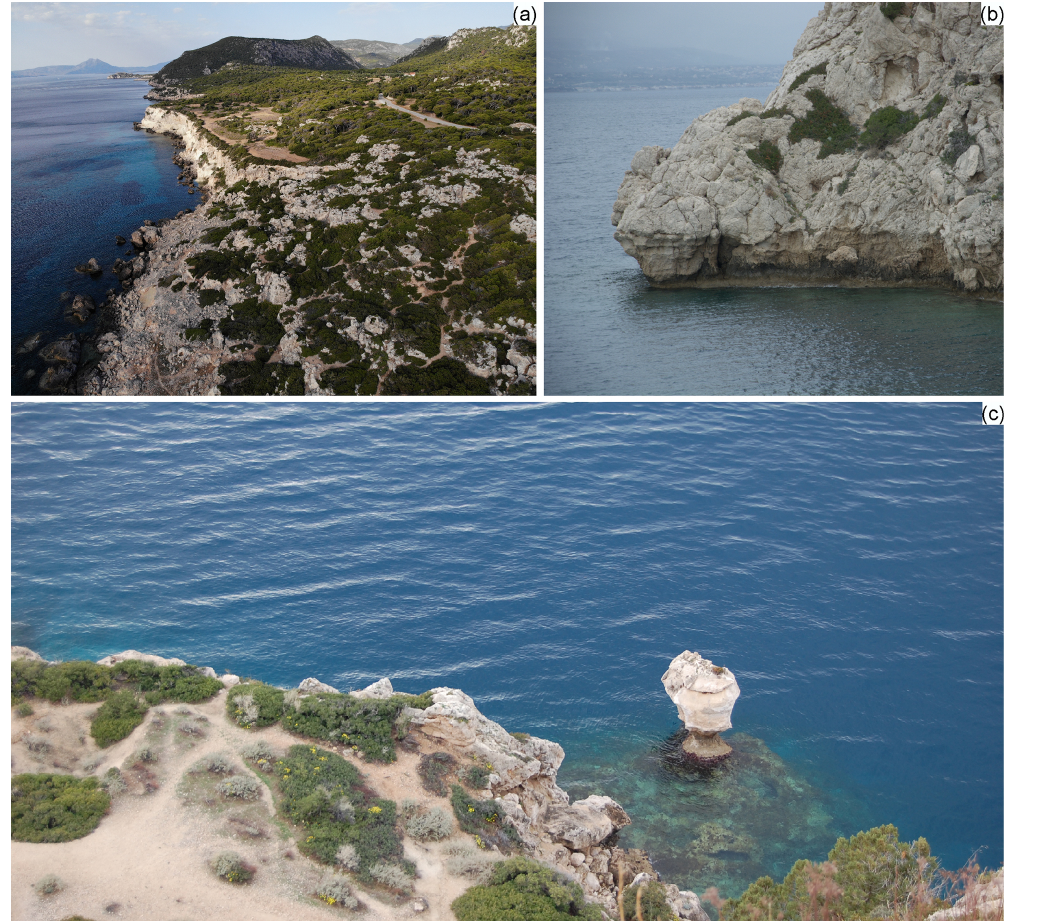
Figure 6. Morphotectonic indicators in Perachora Peninsula, revealing an uplifting regime in the area from Late Quaternary to Holocene, in the form of (a) Pleistocene marine terrace at about 20–25m, which was dated at about 128 ± 3ka, based on a sample of Cladochora caespitosa (Vita-Finzi, 1993). (b) Multiple remains of uplifted tidal notches were studied by Pirazzoli et al. (1994) at altitudes of + 3.2 ± 0.2, + 2.6 ± 0.2, + 1.7 ± 0.2 and + 1.1 ± 0.2m, documenting uplift events since 440–4320BCE. (c) Characteristic mushroom-shaped rock,